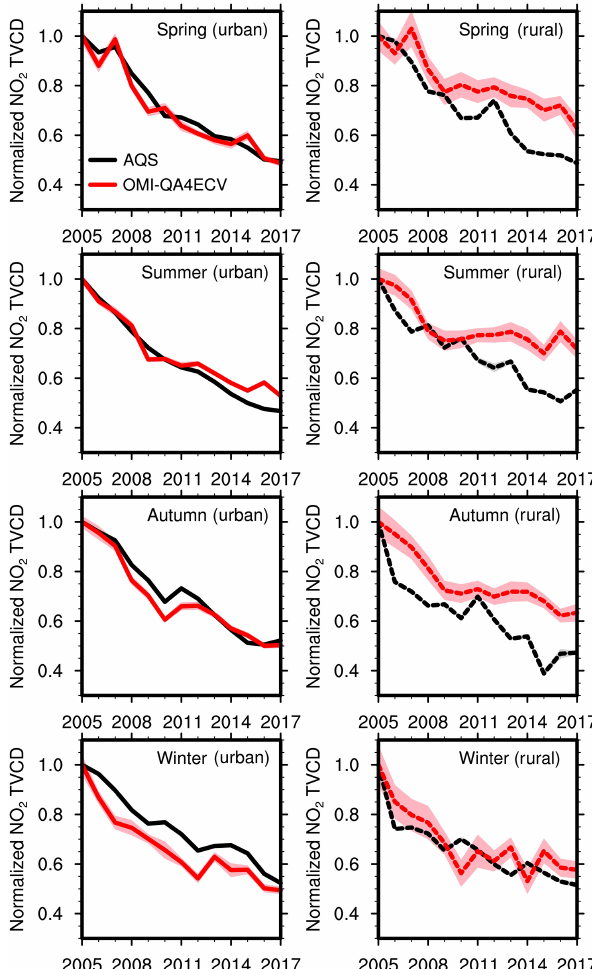
Figure 4. Relative annual variations in AQS NO 2 surface concen- trations and coincident OMI-QA4ECV NO 2 TVCD in each sea- son from 2005 to 2017 for urban (left column) and rural (right col- umn) regions. The observation data are scaled by the corresponding 2005 values. Black and red lines denote AQS surface observations and OMI-QA4ECV NO 2 TVCDs, respectively. Shading in a lighter color is added to show the standard deviation of the results; when uncertainty is small due in part to a large number of data points, shading may not show